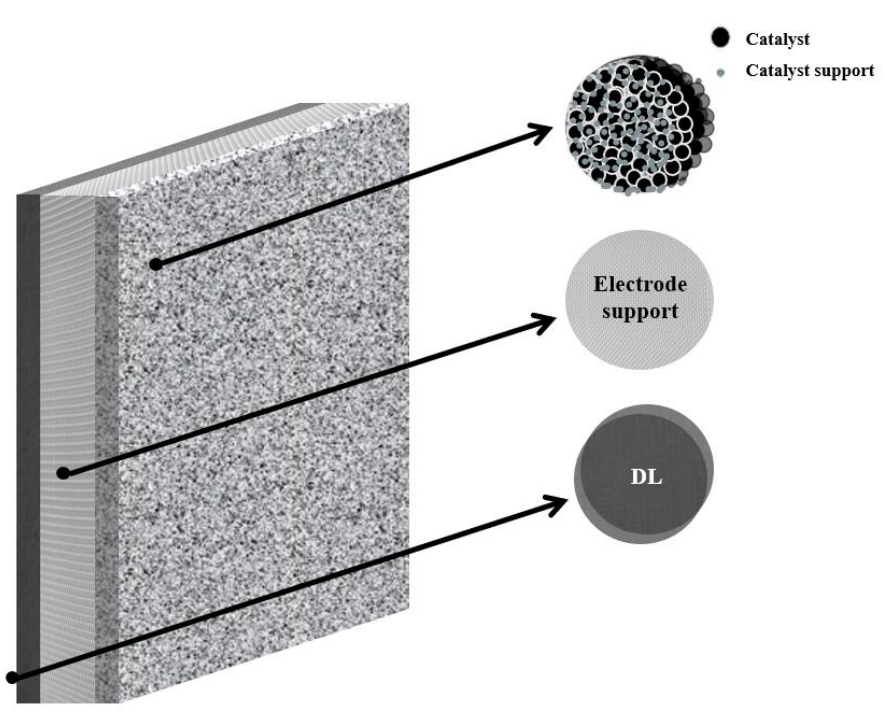
Figure 4. Cathodic surface layers (DL-diffusion layer).